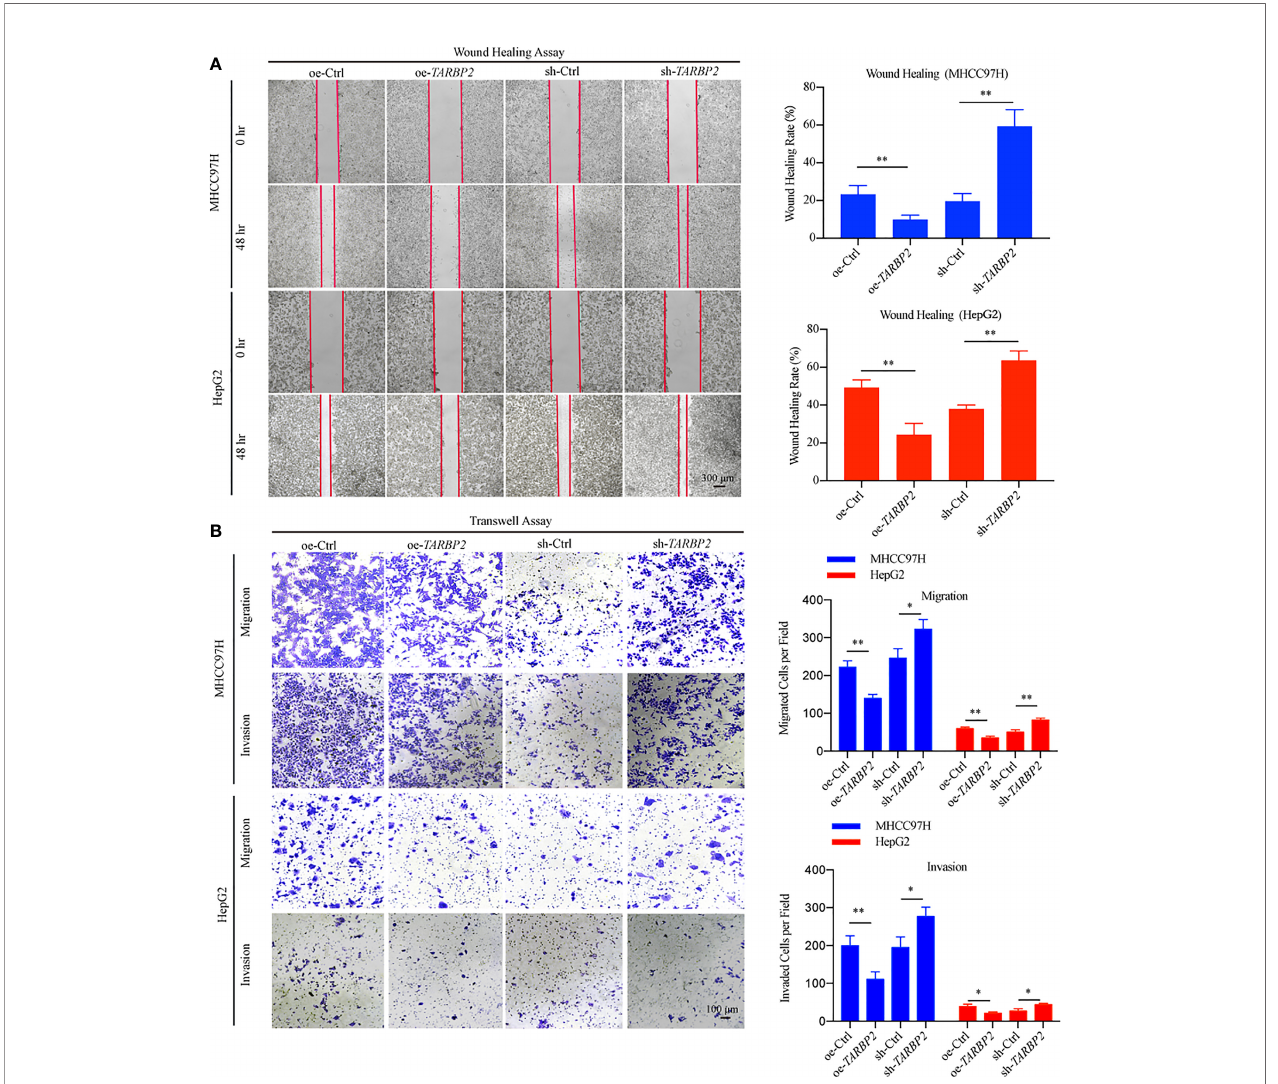
FIGURE 3 | TARBP2 affects migration and invasion of HCC cells. (A, B) TARBP 2 overexpression suppressed the migration and invasion of the HCC cells compared with controls. TARBP2 knockdown shown an opposite effect according to the results of wound healing and transwell assays. *p-value < 0.05; **p-value <